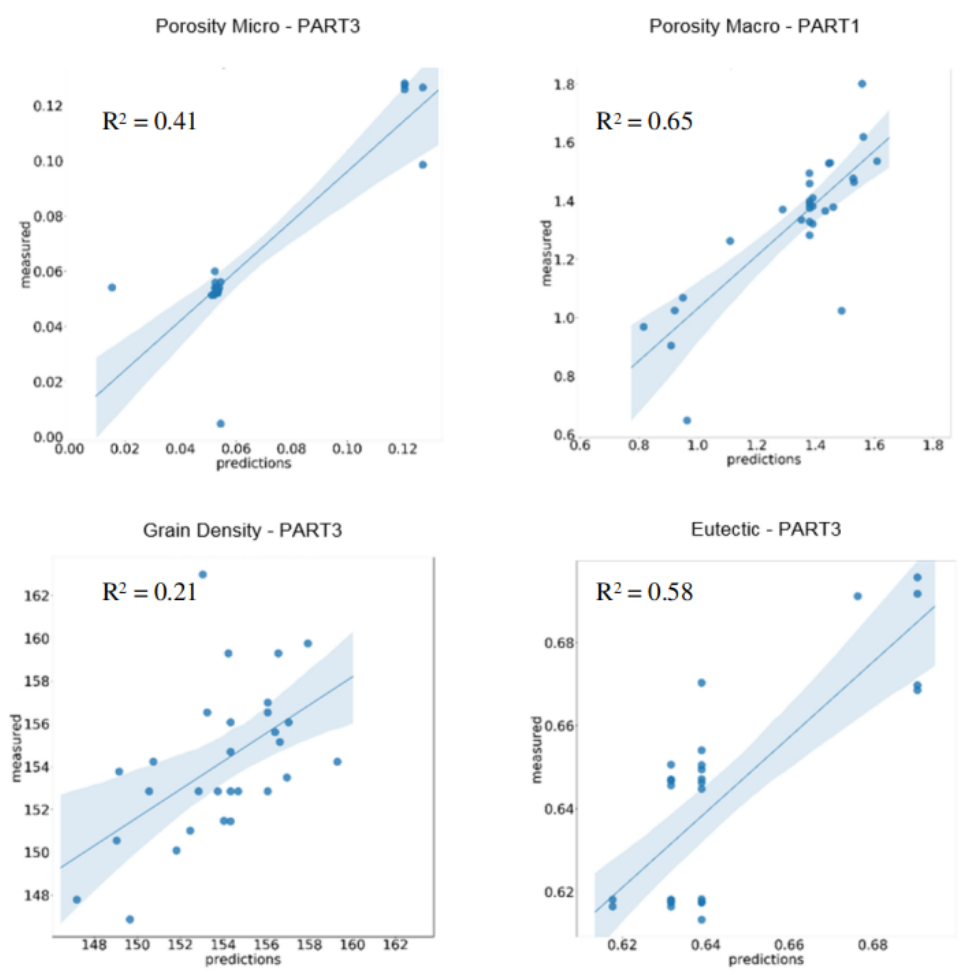
Figure 17. Examples of the results provided by the metamodels for microporosity and macroporosity, grain density and